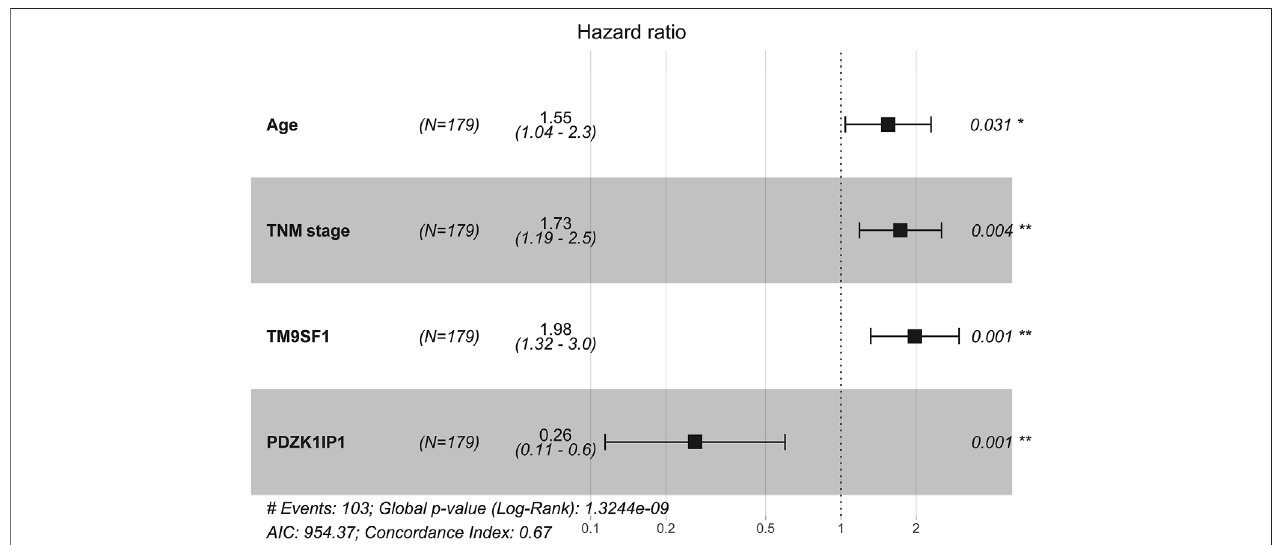
FIGURE 4 | Multivariate cox analysis of the gene set and clinicopathologic characteristics from primary Cohort ( N = 179).